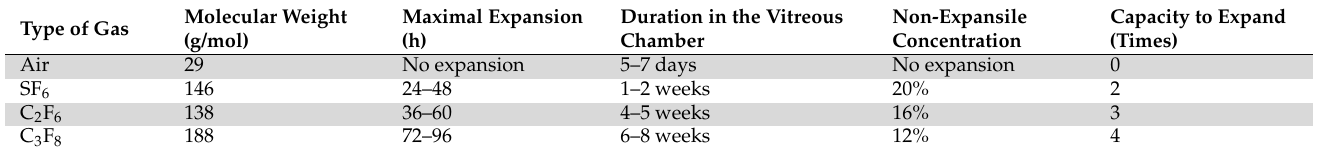
Table 1. Properties of the gases commonly utilized in vitreoretinal surgery.